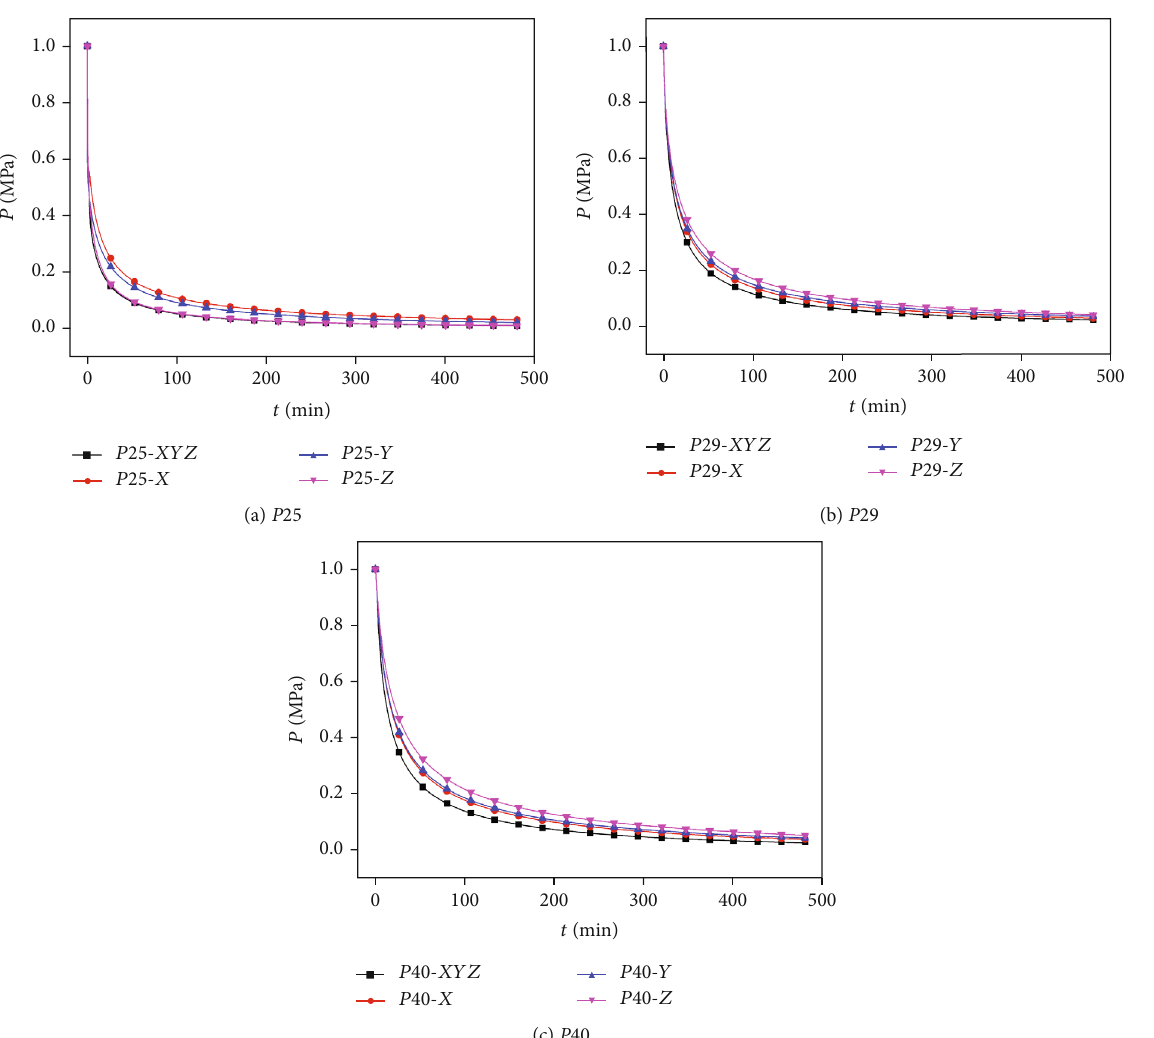
Figure 5: Drainage e ff ect of pressure relief gas drainage.